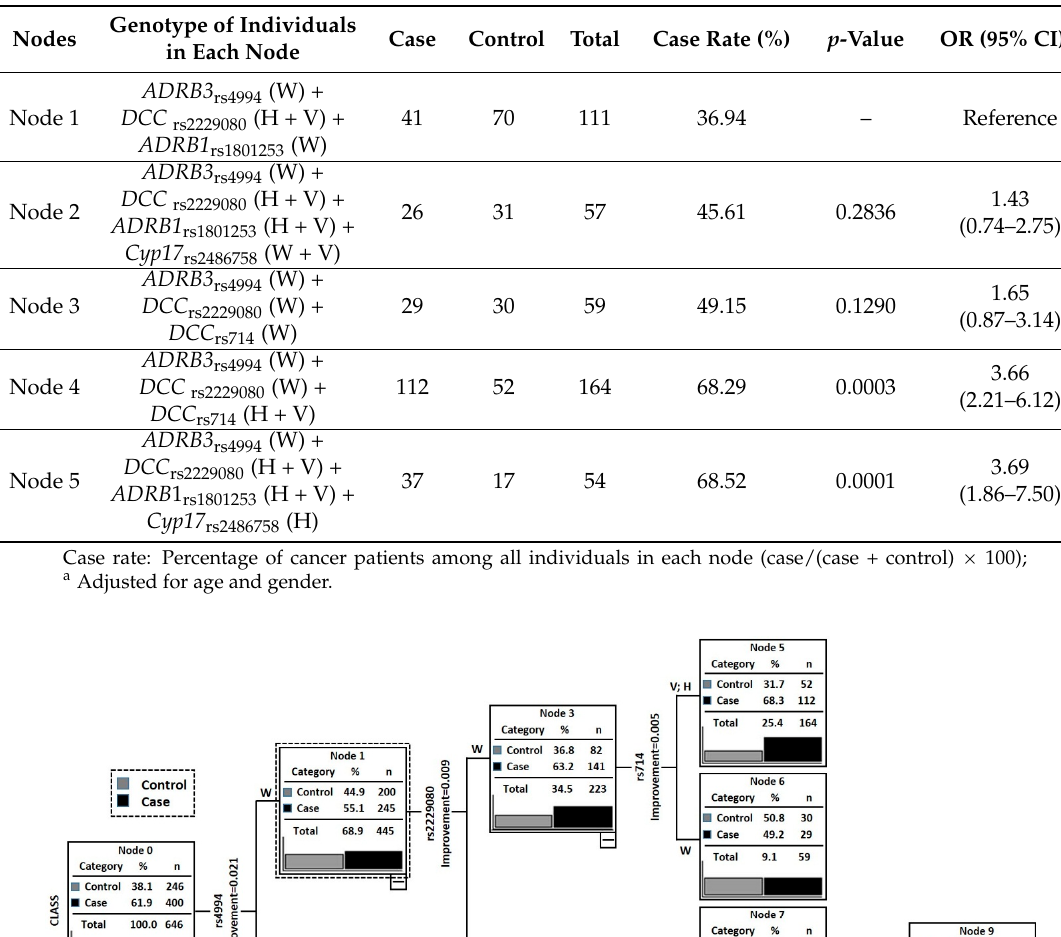
Table 4. Risk estimate based on Classification and Regression Tree Analysis (CRT) terminal nodes.